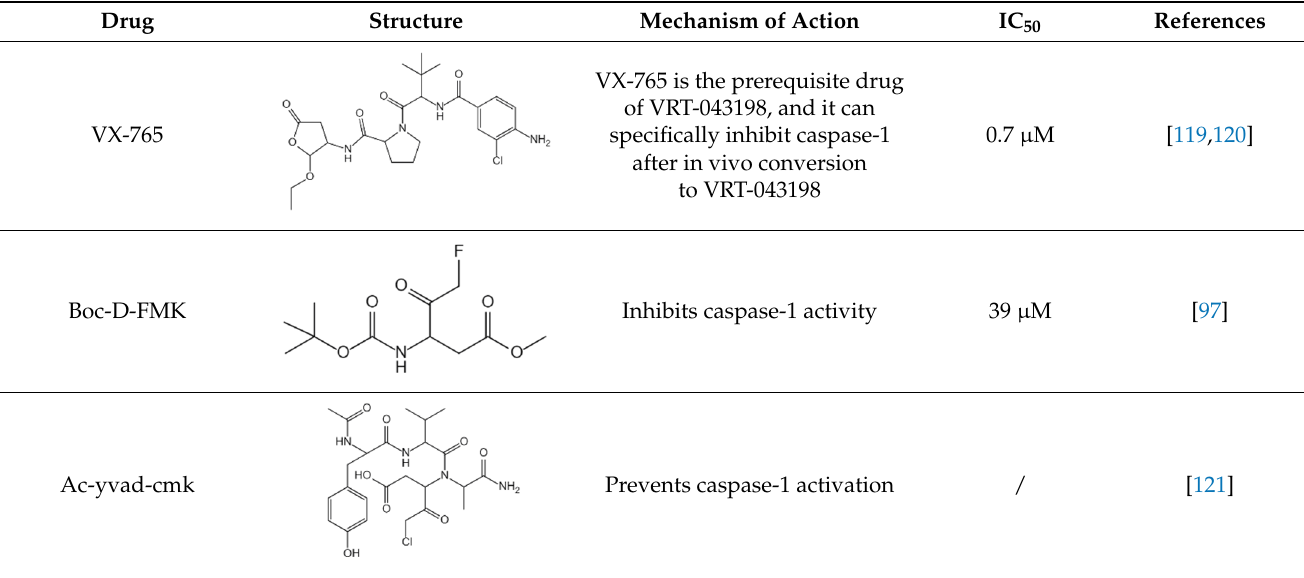
Table 2. Pyroptotic inhibitors targeted to caspase-1.